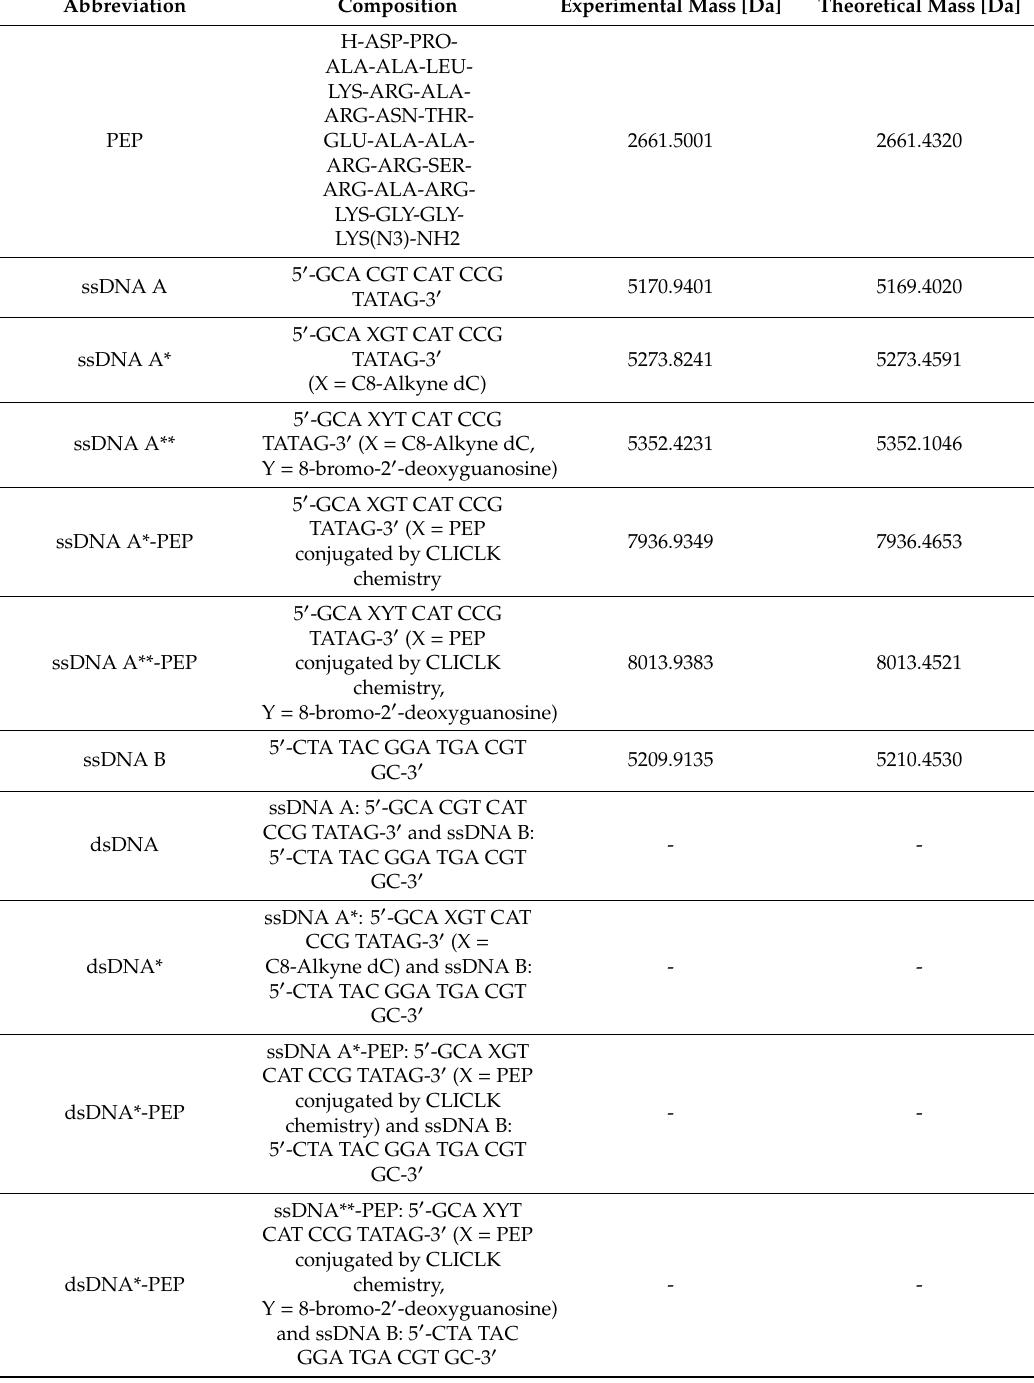
Table 1. List of all abbreviation used and their respective sequences and calculated and experimental masses given by mass